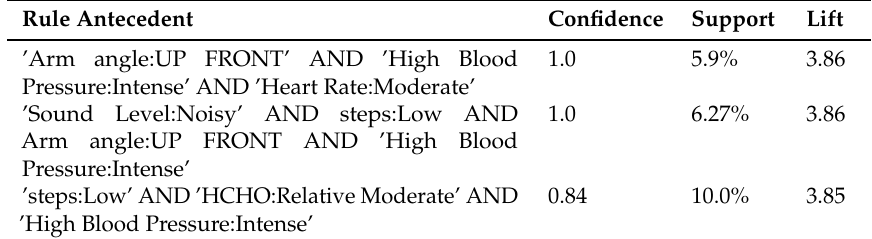
Table 2. The derived rules from the application of machine learning techniques looking at high differences in blood pressure and explaining the intense values.